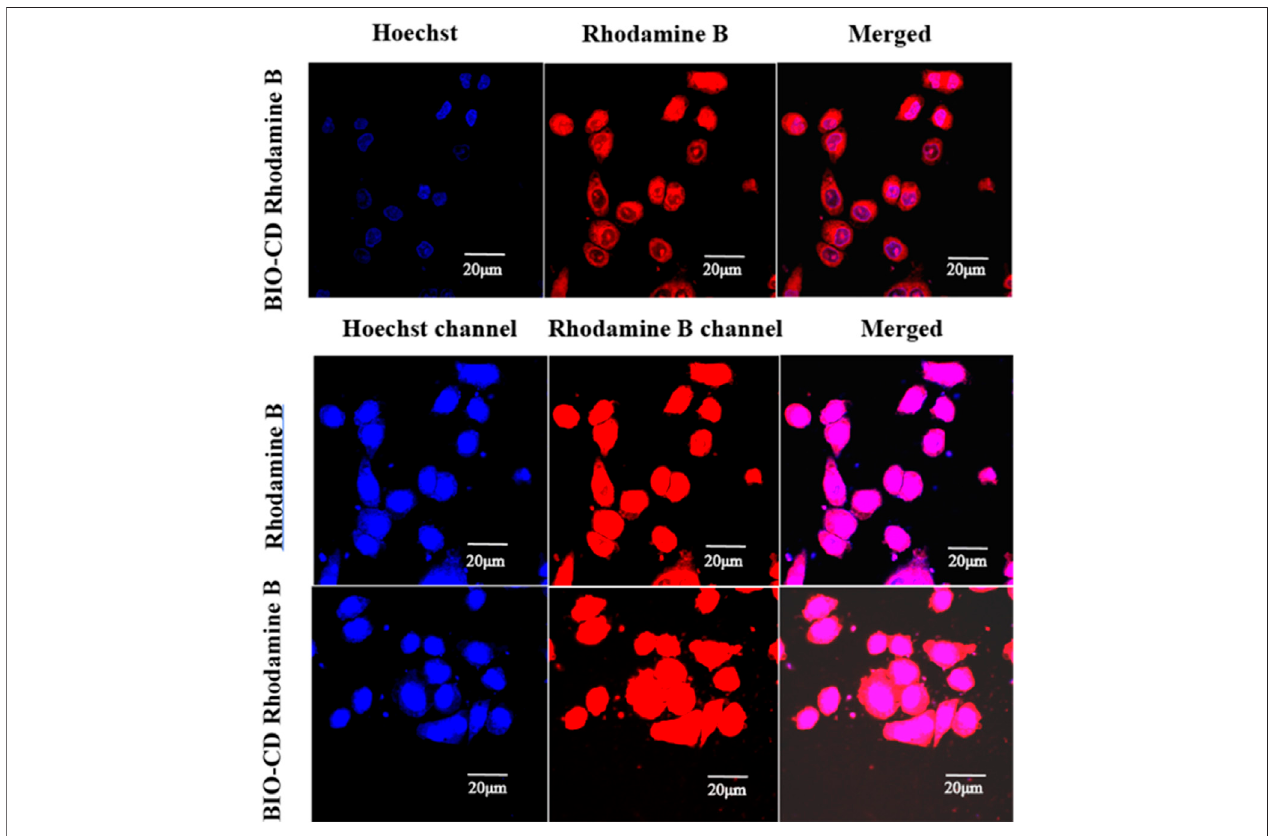
FIGURE 13 | The CLSM images of A549 cells after 4 h of incubation with Rhodamine B-loaded BIO-CD. The cell nuclei are stained with Hoechst (blue fl uorescence). Rhodamine B (red fl uorescence) is visible.